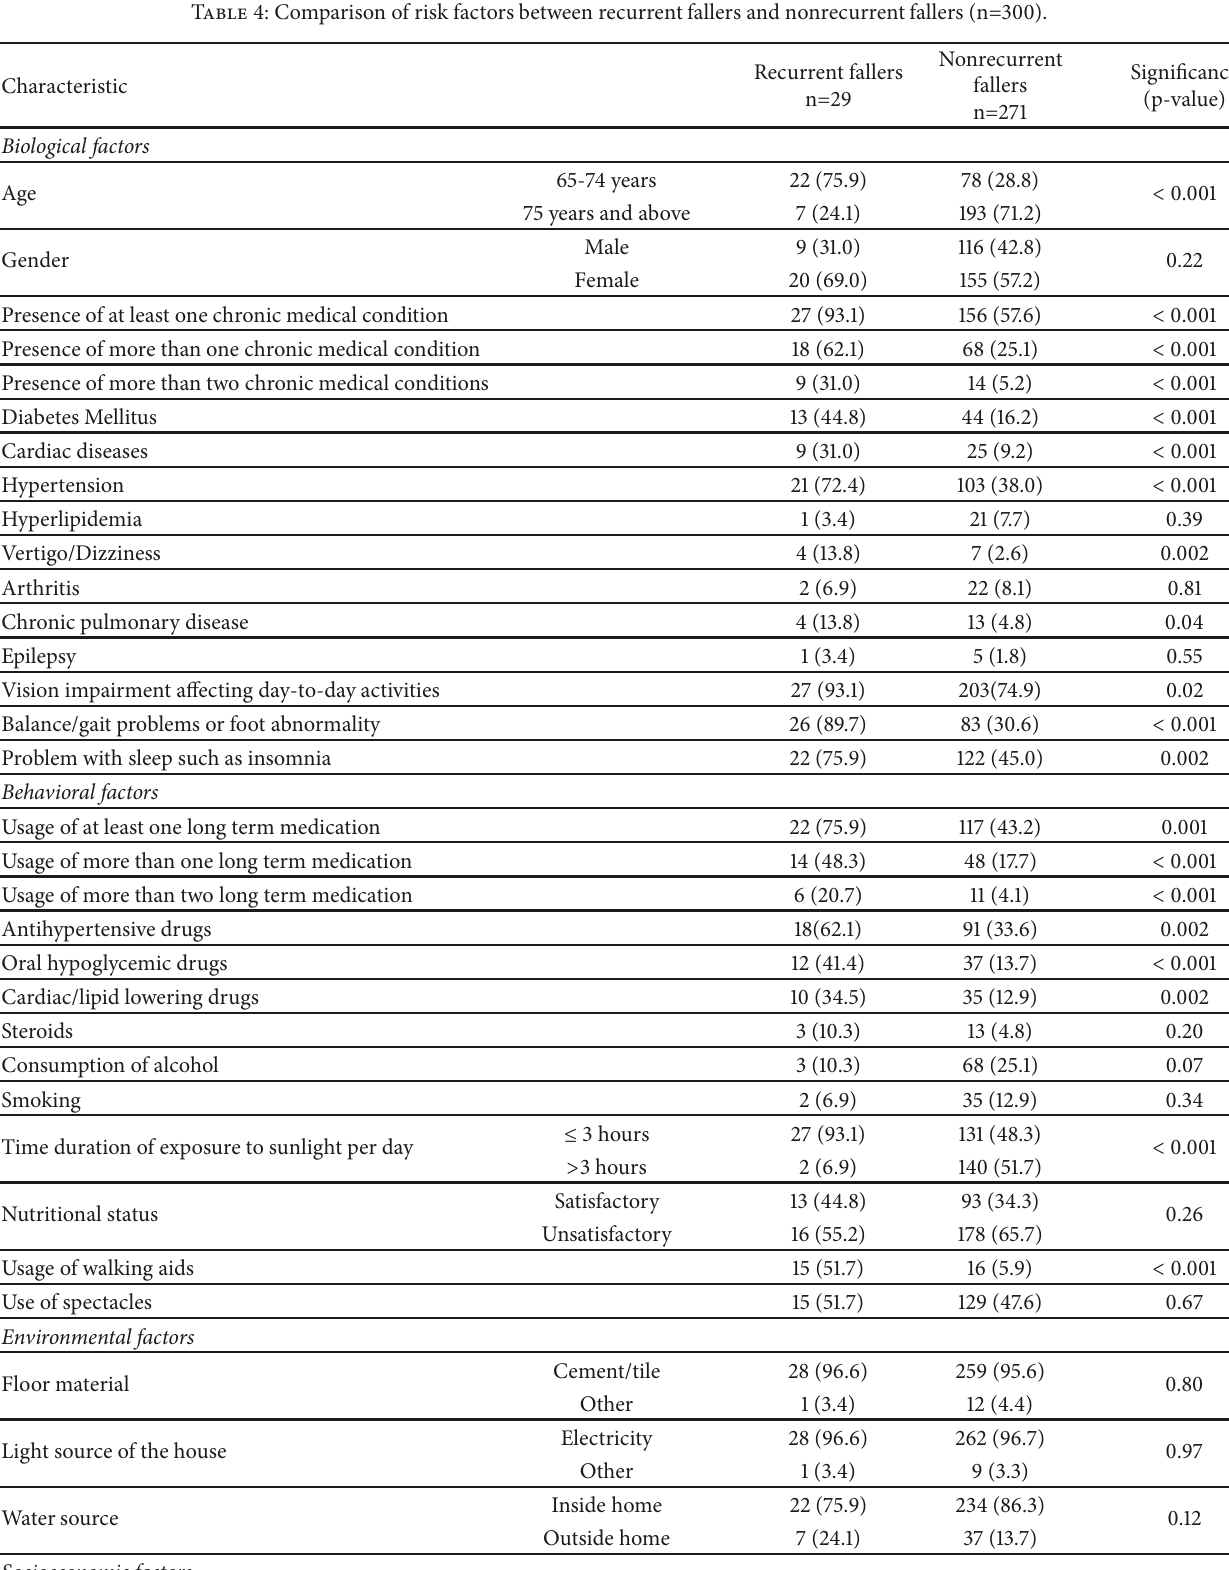
Table 4: Comparison of risk factors between recurrent fallers and nonrecurrent fallers